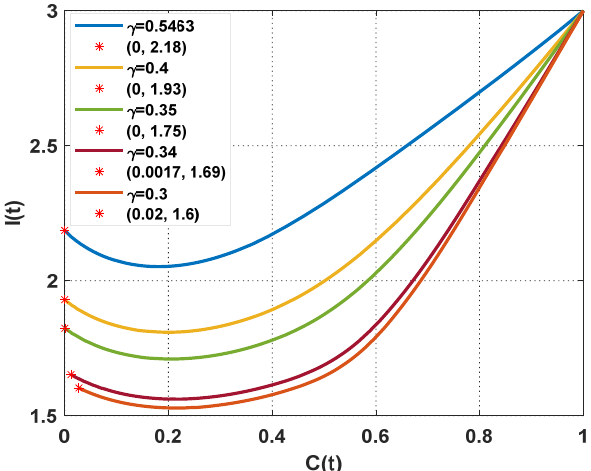
Figure 6. Phase portrait of the CICV model for the data given in Table 1 with γ = 0.5463,0.4,0.35,0.34 and 0.3 .